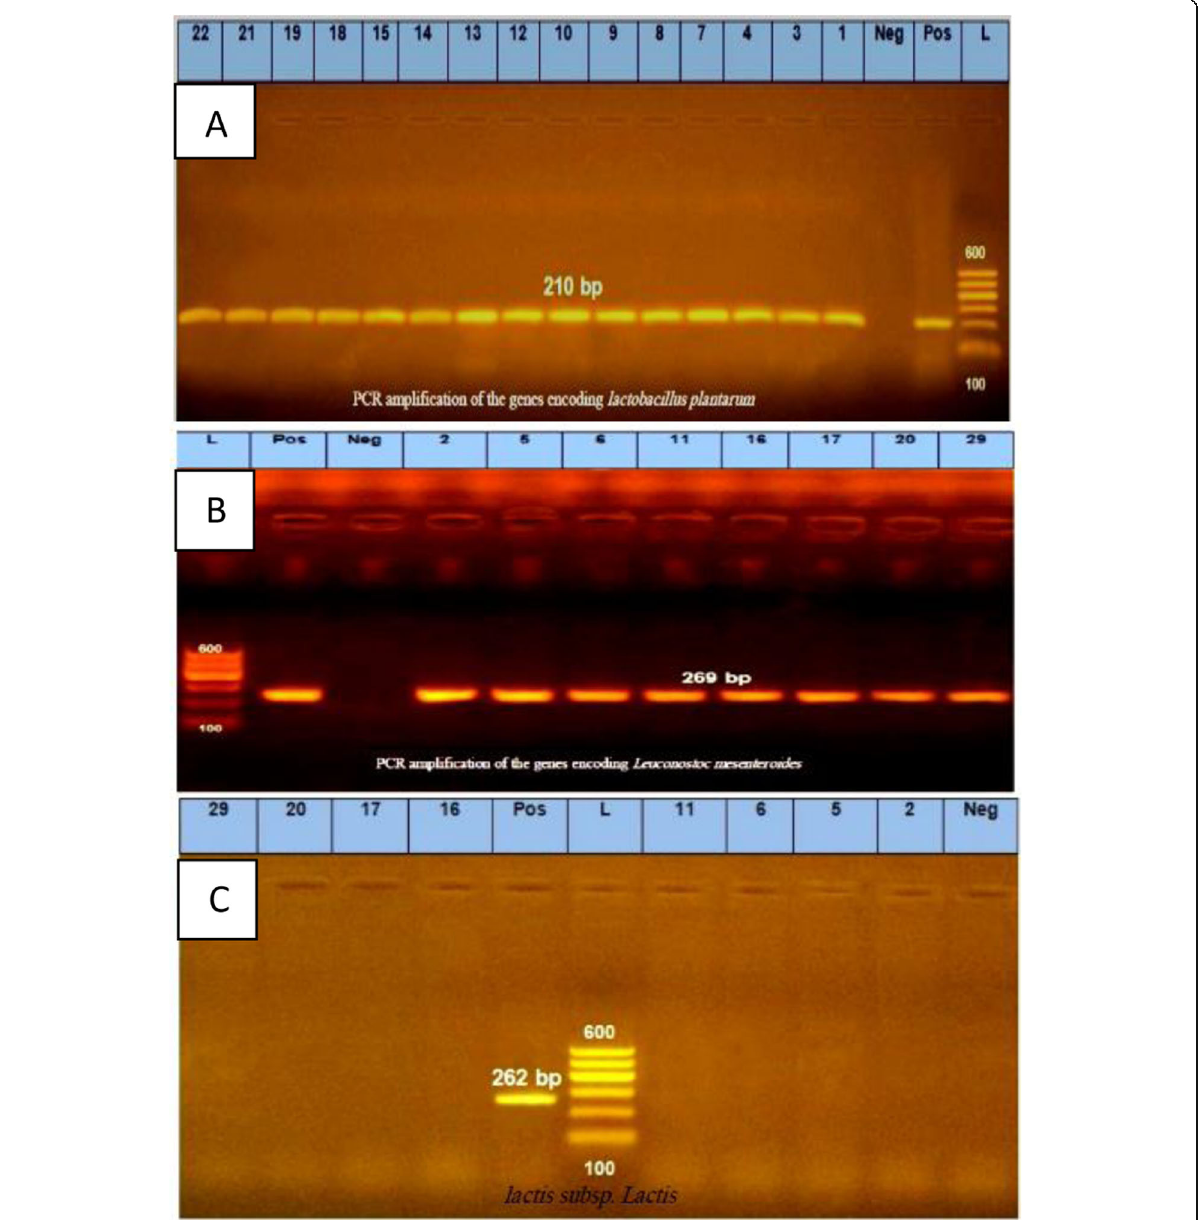
Fig. 2 Amplification products obtained from lactic acid bacterial isolates using the recA gene primers. a PCR product of the genes encoding Lb . plantarum . b PCR product of the genes encoding Lc . mesenteroides . c PCR product of the genes encoding Lactococcus lactis subsp. lactis . Lane L, 1000 bp ladder. Lane Neg, negative control. Lane Pos, positive control; lane numbers (1, 2, 3...) amplicons from DNA isolated from selected LAB